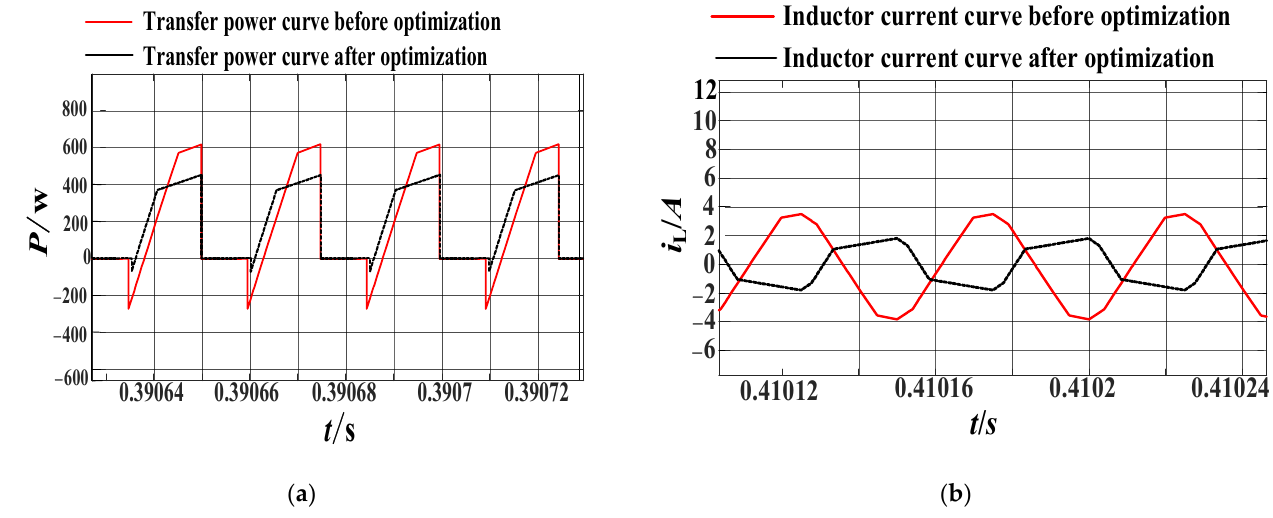
Figure 15. Power/inductor current curve of the converter: ( a ) power curve; ( b ) inductor current curve.